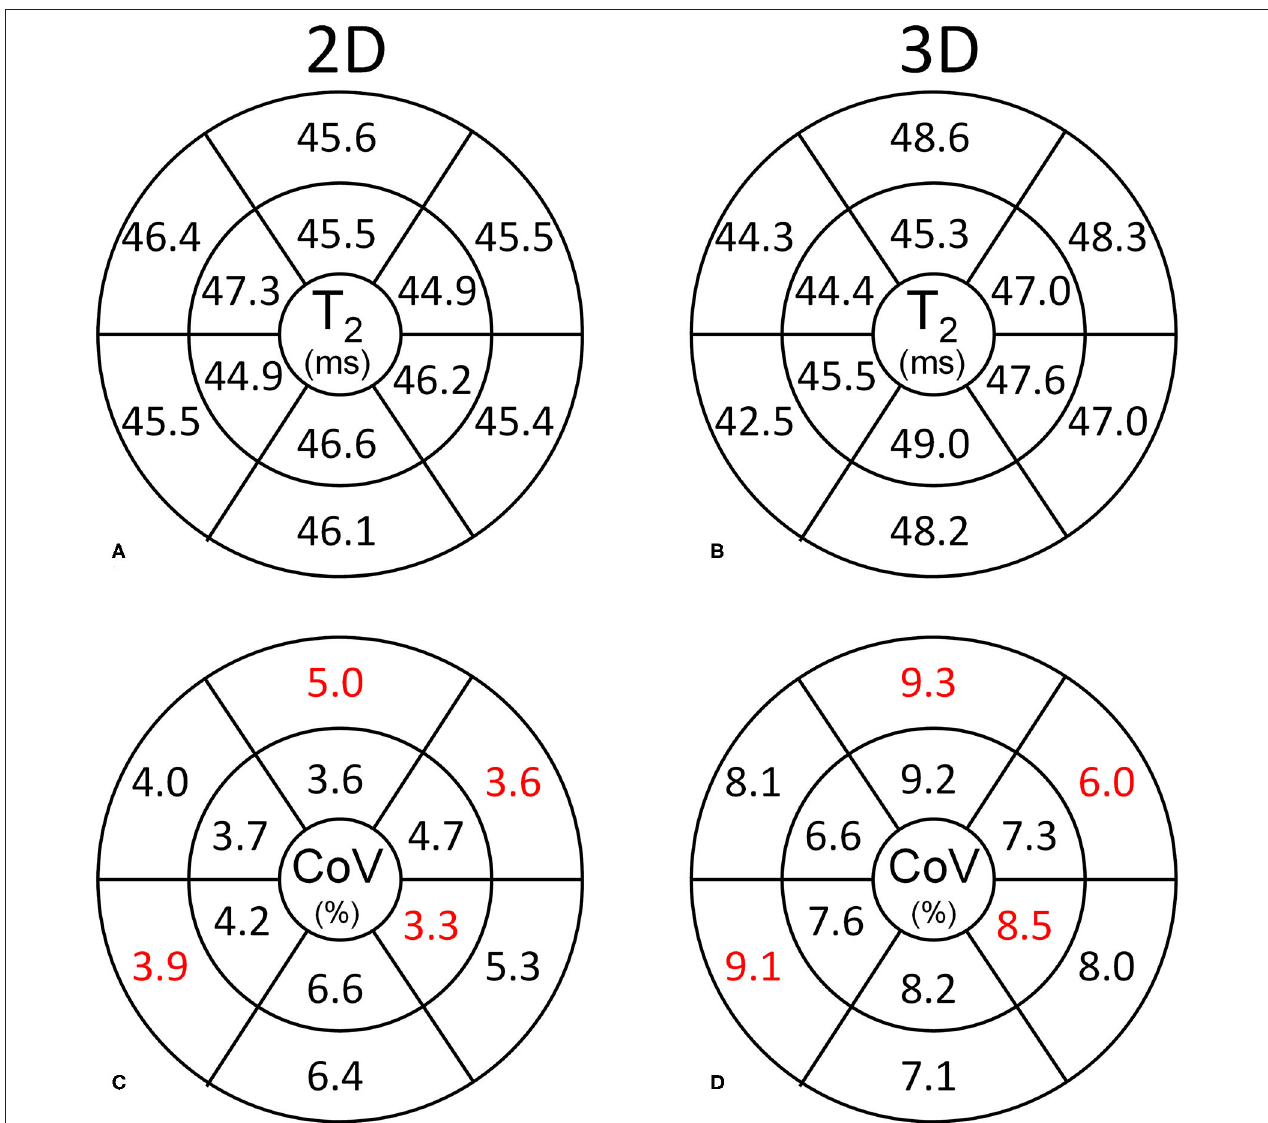
FIGURE 3 | Segmental analysis of the myocardial T 2 values in the healthy volunteers. Basal and mid-ventricular segmental T 2 values and CoVs are shown according to the standard AHA segmentation. (A,B) The segmental T 2 values obtained with the 2D and 3D techniques are highly similar. (C,D) The CoV is consistently lower for the 2D technique than for the 3D technique. Significantly different CoV values between the respective segments are marked in